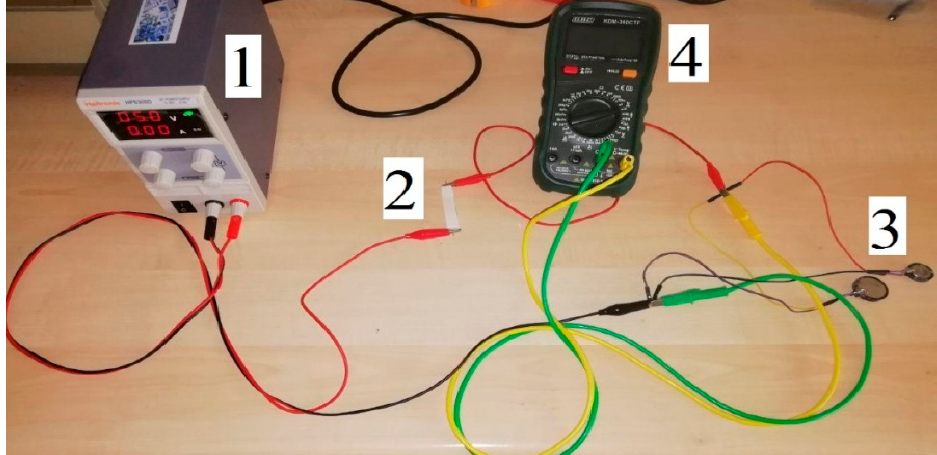
Figure 5. Image of the experimental setup for the charging of all employed SCs (specifically type-A and -B SCs indicated as device 3).